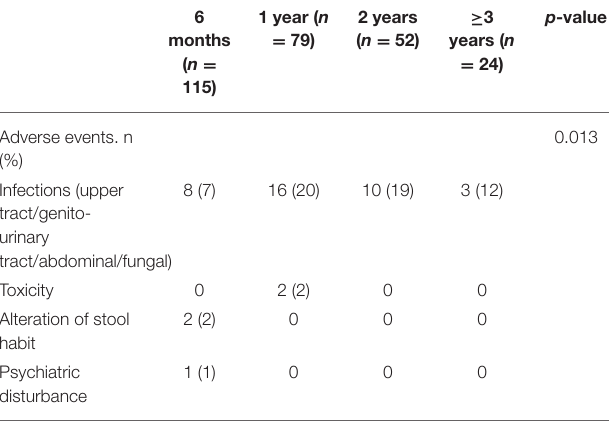
TABLE 5 | Adverse events